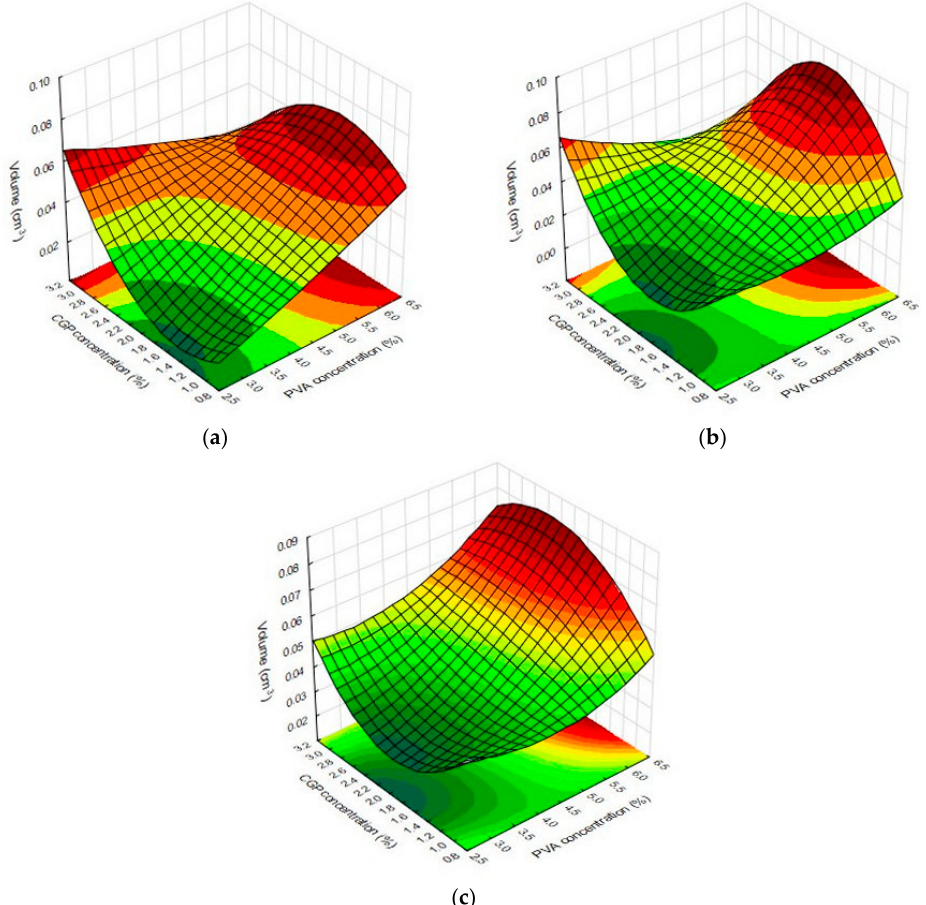
Figure 4. Response surface plots for the dimension changes of CGP/PVA films in ( a ) acetate buffer, ( b ) water and ( c ) glycine buffer as function of the significant factors.